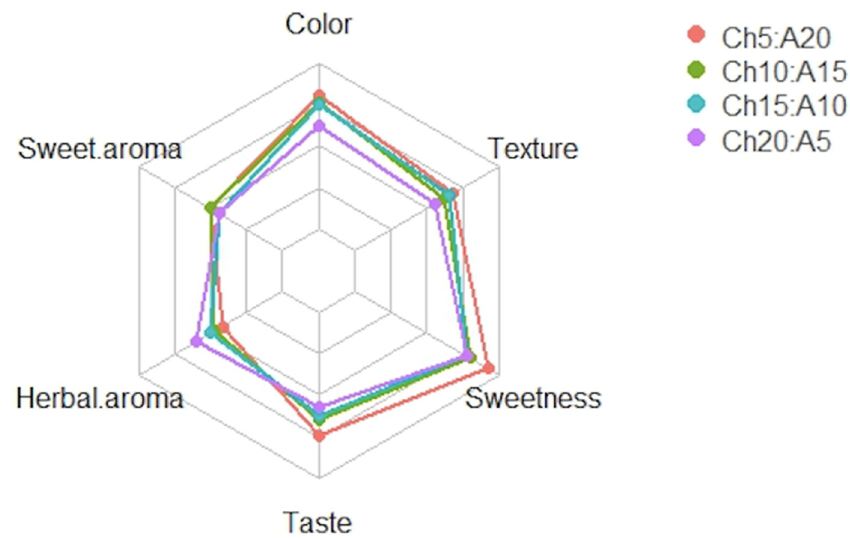
Figure 4. Overall sensorial analysis of different formulations of cookies. Ch5:A20: 40 g of wheat flour + 5 g of chaya flour + 20 g of amaranth flour; Ch10:A15: 40 g of wheat flour + 10 g of chaya flour + 15 g of amaranth flour; Ch15:A10: 40 g of wheat flour + 15 g of chaya flour + 10 g of amaranth flour; and Ch20:A5: 40 g of wheat flour + 20 g of chaya flour + 5 g of amaranth